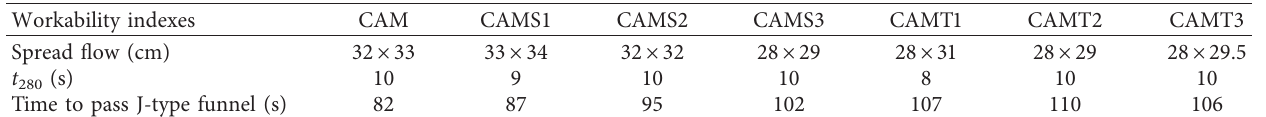
Table 4: Workability of fresh